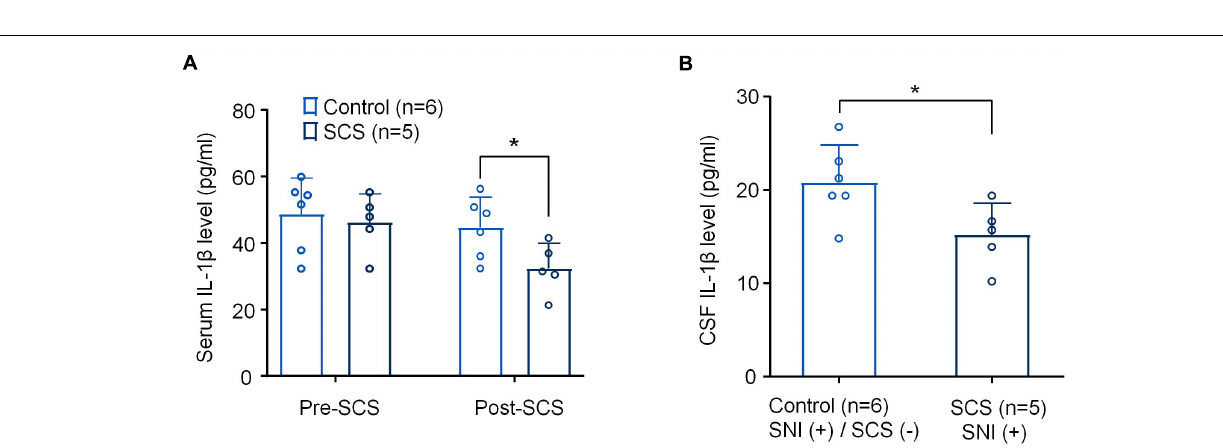
Together, these results suggest (1) SCS differentially regulated IL-1 β and RvD1 levels and (2) SCS differentially regulated serum and CSF levels of